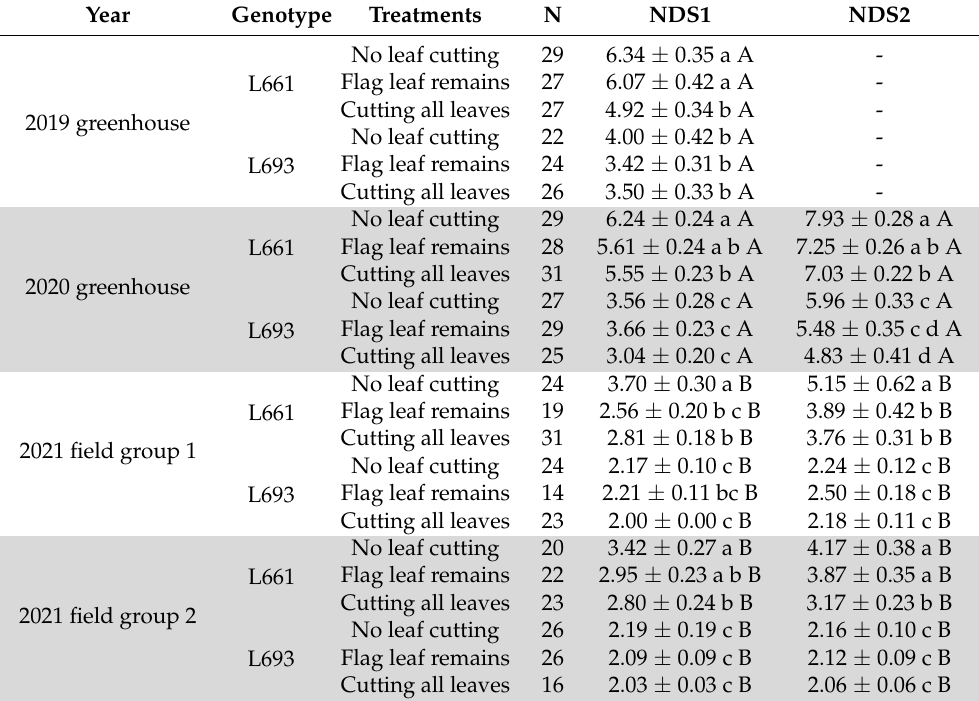
Table 1. Evaluation FHB resistance and yield indices in the greenhouse and